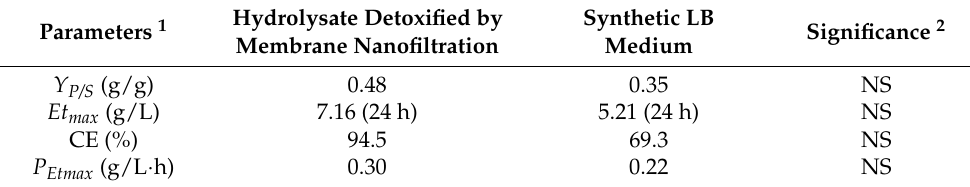
Table 4. Kinetic and stoichiometric parameters obtained in the fermentations with E. coli MS04 using the synthetic LB medium and the hydrolysate detoxified by